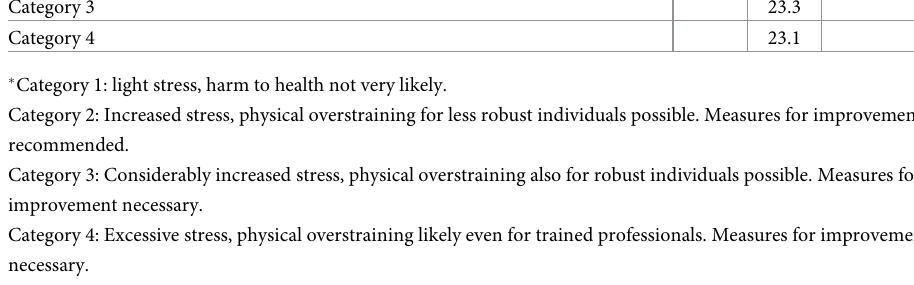
Spontaneous abortions (Fig 6) were not significantly associated with water carrying-related predictors. Pain in the neck was not significantly associated with any of the factors included in the model. Data tables of all six models are provided in S4 Table Association of risk factors with uterine prolapse, abortions, strong back pain, neck pain, pain in the hips, pain in the knees in multivariate GLMM in the supplementary materials.